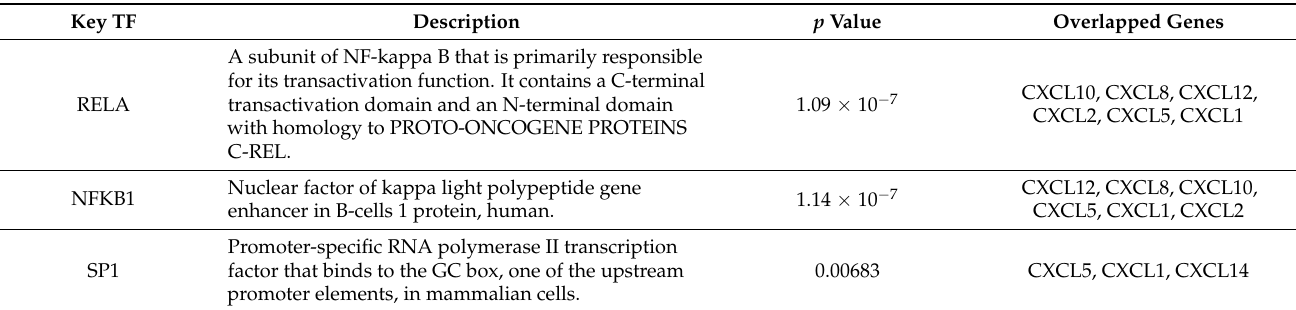
Figure 8. Prediction of TFs regulating CXCs. ( A ) TFs and regulatory relationships searched in the TRRUST database. The red line represents the activation regulatory relationship, the blue line represents the repression regulatory relationship, and the grey line represents the unknown regulatory relationship. ( B ) TFs and corresponding intergenes searched in the KnockTF database. The grey line represents ChIP-seq data supporting TF–target relationships. ( C ) Intersections of these two databases. Table 2. Key transcription factor of CXCs.